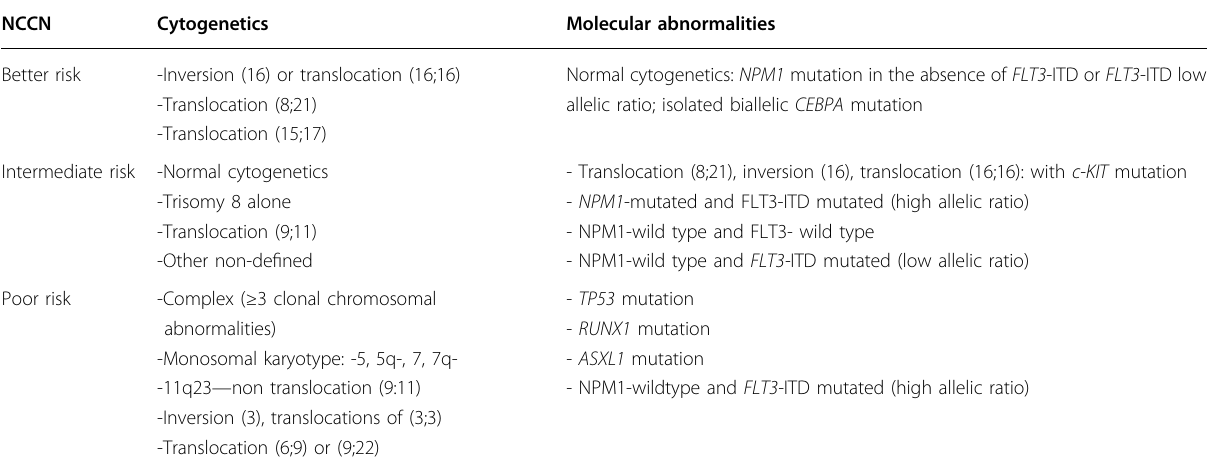
Table 2 Cytogenetic-molecular entities in acute myeloid leukemia (NCCN classi fi